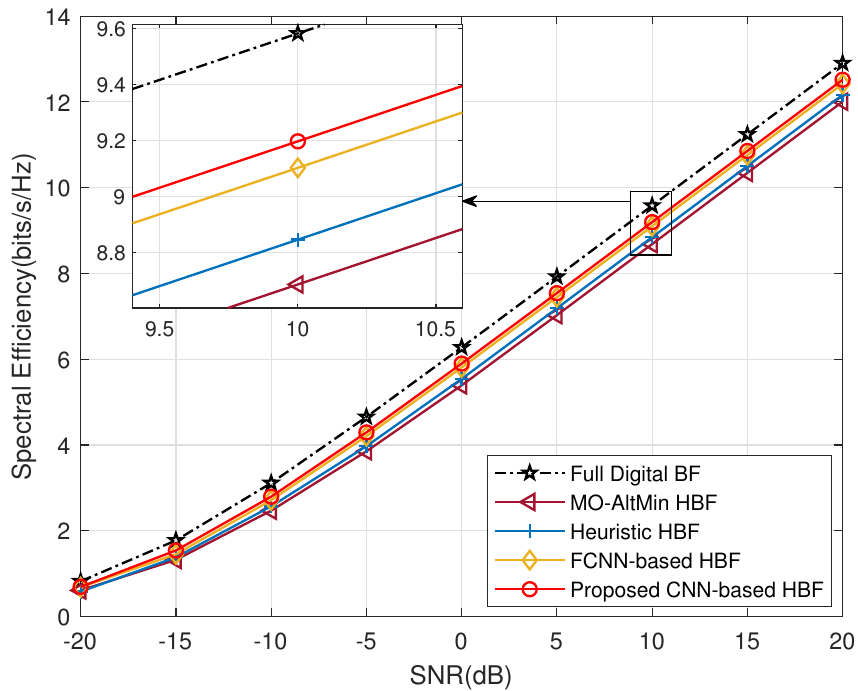
Figure 9. Comparison of spectral efficiency performance under different schemes in geometric mmWave channel with N t =